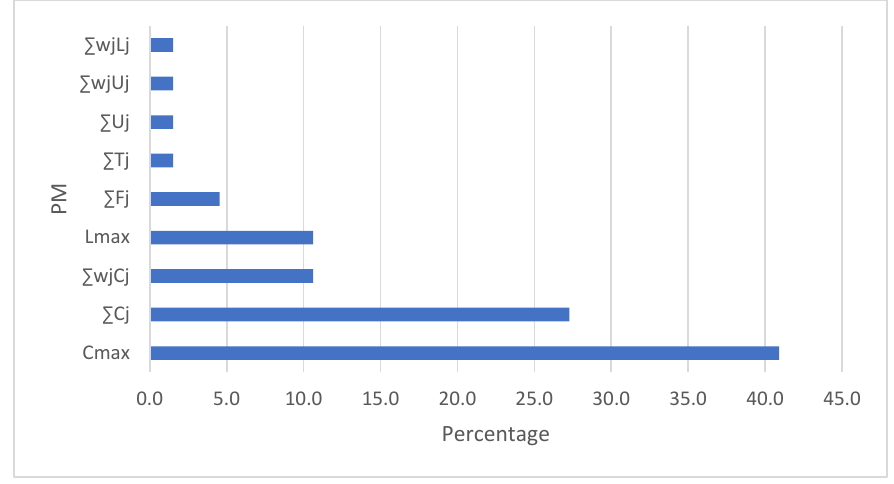
Fig. 1. Percentage of addressed problems with respect to PM.